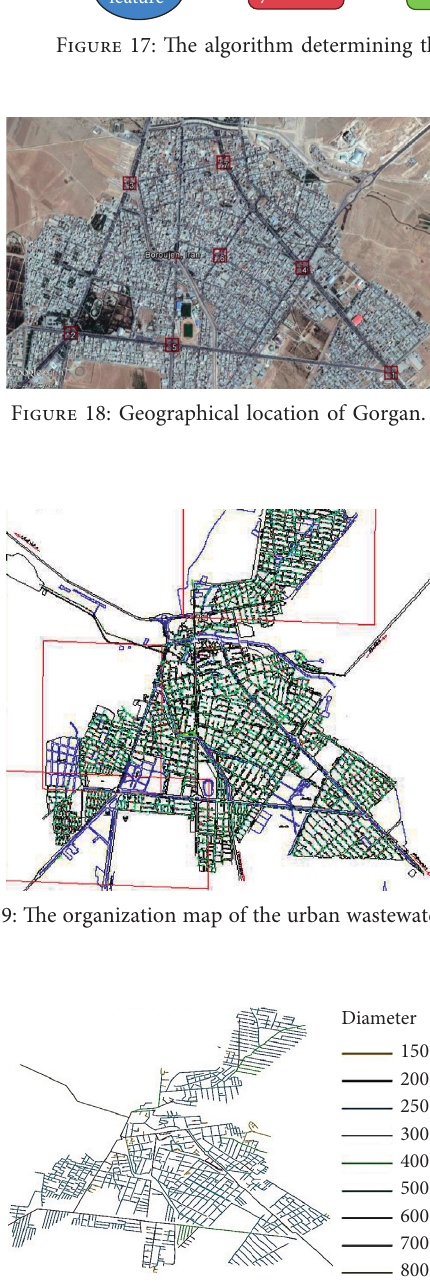
Figure 20: The map of Borujen wastewater system (diameter of pipes).